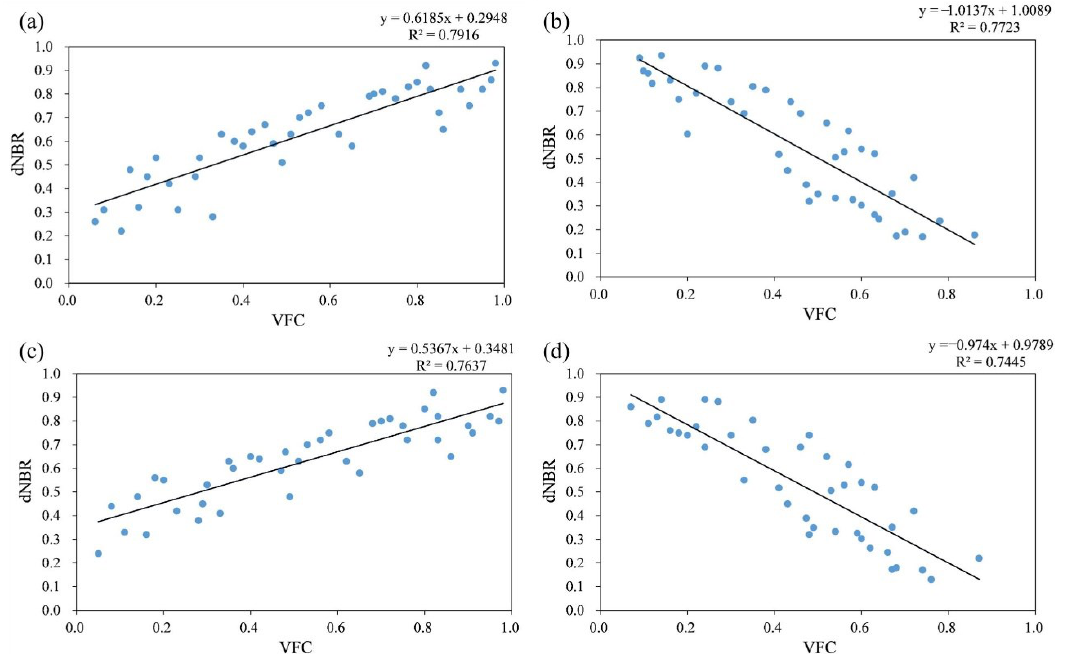
Figure 10. The relationship between vegetation coverage before and after fire, and dNBR. ( a , b ) the fitting curves of VFC before and after the fire, and dNBR in Muli County, respectively, ( c , d ) the fitting curves of VFC before and after the fire, and dNBR in Jingjiu Township, respectively.